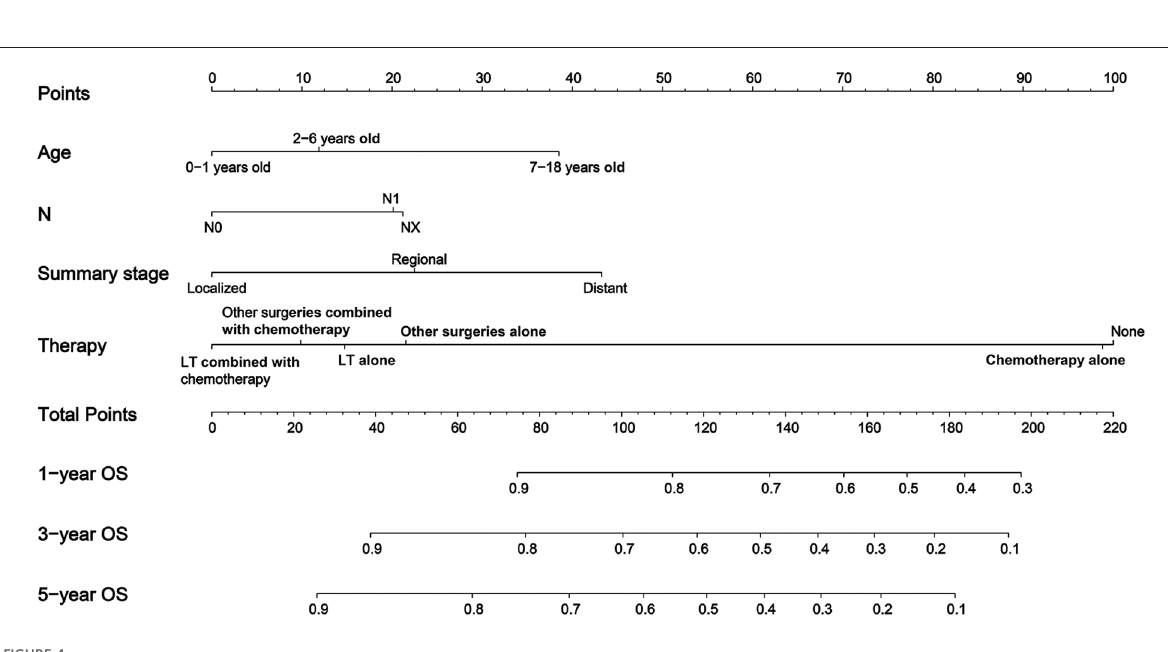
FIGURE 4 Nomogram for predicting the OS of children with liver cancer. OS, overall